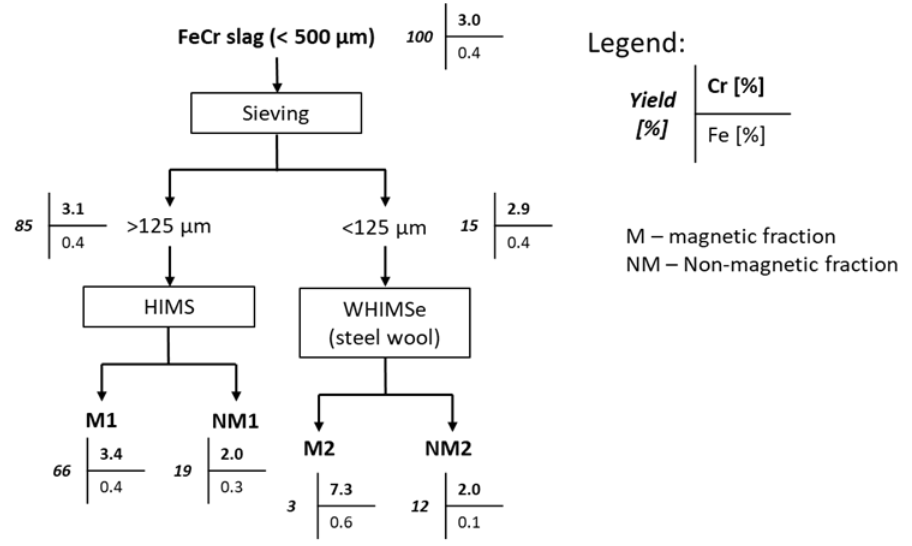
Figure 4. Processing flowsheet for LC FeCr slag.